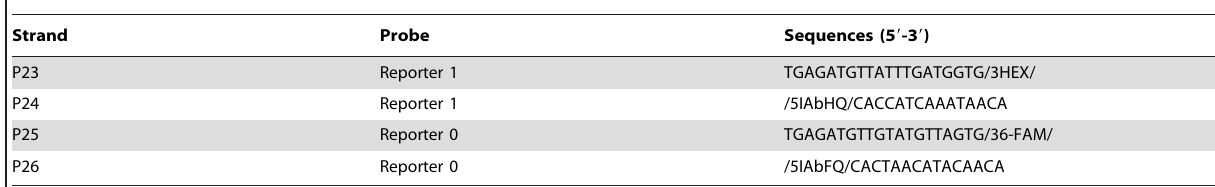
Table 5. Probes with